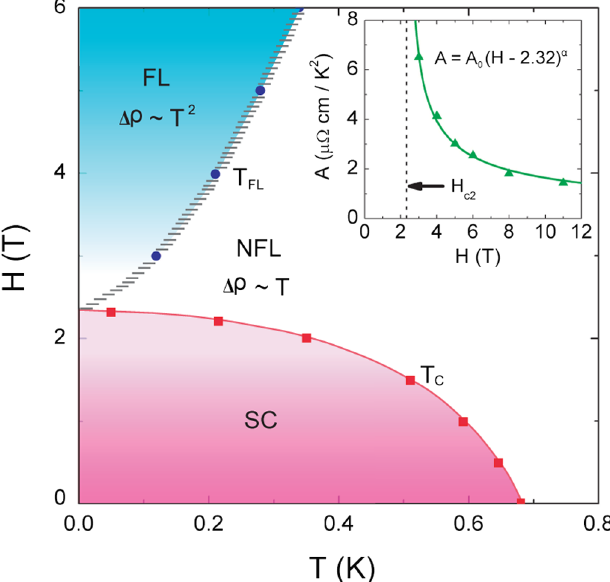
FIG. 2. The H (cid:2) T phase diagram of Ce 2 PdIn 8 determined from the resistivity measurements. The T c is defined at 10% of the normal-state resistivity in each field. The T FL is defined as the upper limit of the temperature range of T 2 -dependence Fermi liquid behavior. This phase diagram suggests a field-induced quantum critical point located at H c 2 ¼ 2 : 32 T . The inset shows the field dependence of the coefficient A of (cid:1) ¼ (cid:1) 0 þ AT 2 , which tends to diverge toward H c 2 ¼ 2 : 32 T